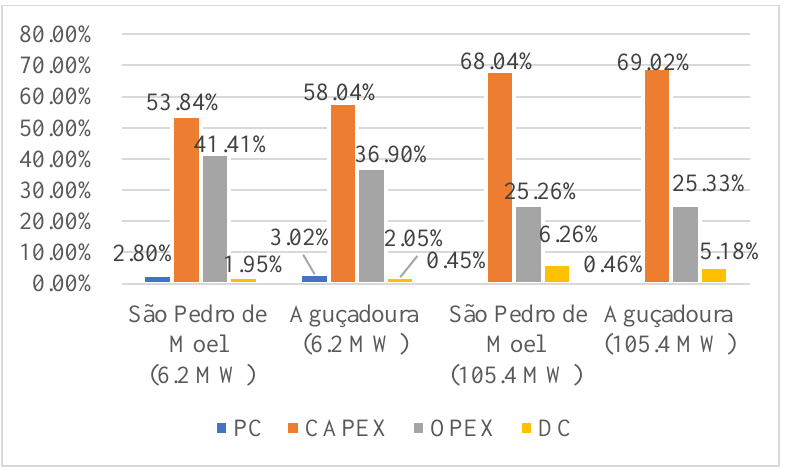
Figure 7. Percentage of the cost center towards total cost of Poseidon technology (Note: Figure does not show discounted cost for the 100-unit Pelamis installation). Table 2. Decommissioning